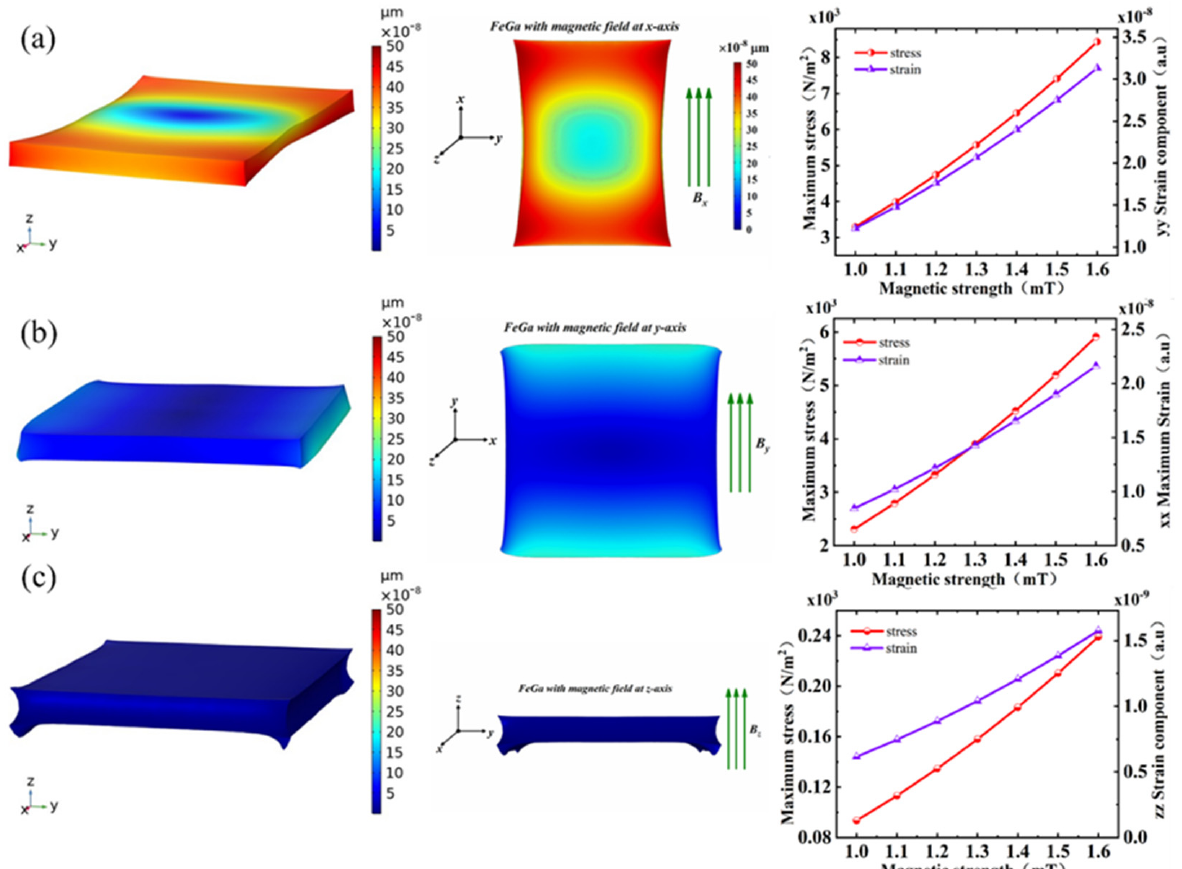
Figure 2. The 3D displacement distribution of Fe–Ga alloy under 1 mT magnetic field ( left ), 2D displacement distribution of Fe–Ga alloy under 1 mT magnetic field ( middle ), and its maximum stress and strain components as a function of the magnetic field ( right ). The magnetic field is shown along the ( a ) x -axis, ( b ) y -axis, and ( c ) z -axis.